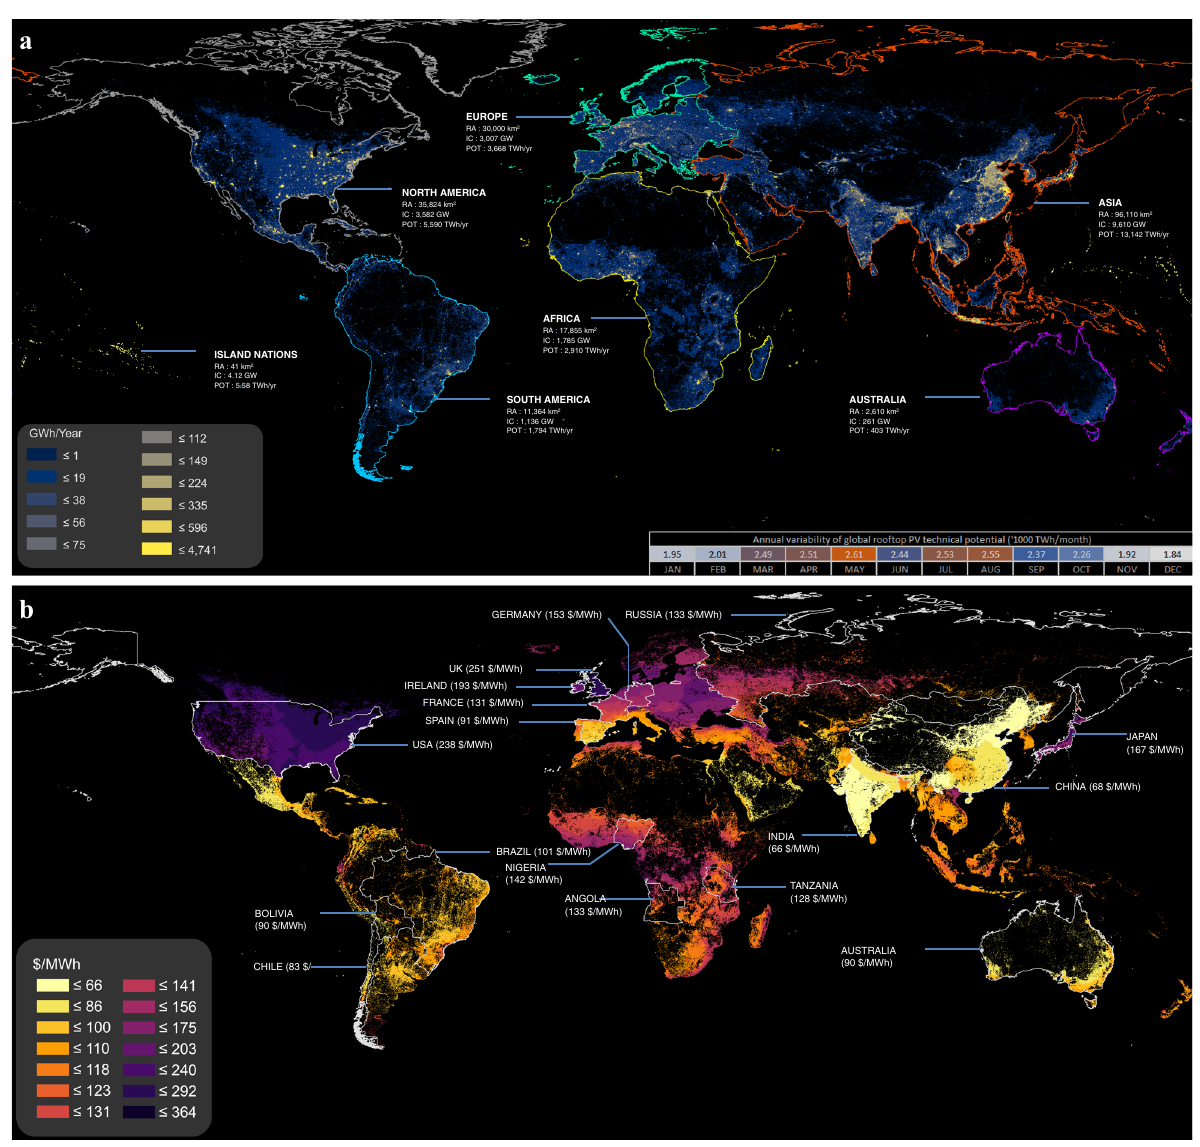
Fig. 5 Global Distribution of RTSPV technical potential and LCOE values. a The geographical distribution of global RTSPV technical potential generated in our study. Major world regions are highlighted in the image and data is provided for the total estimated rooftop area (RA), installed capacity (IC), and potential generation (POT) for each region. The global landmass is color-coded into 11 RTSPV potential bins. Seasonal variation in aggregated global potential is highlighted in the bottom right. b The geographical distribution of LCOE values generated in our study across the globe with major countries highlighted in each world region. Each highlighted country has a corresponding aggregated LCOE value for the whole country. The LCOE values are color- coded into 14 cost bins. Map boundary data from the Database of Global Administrative Areas (GADM: